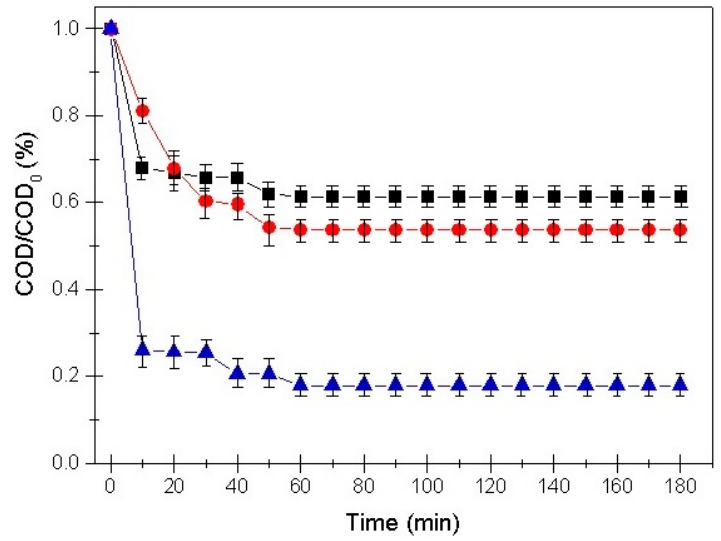
Figure 3. Removal capacity data for chemical oxygen demand (COD) from cold meat industry wastewater as a function of current density using pH = 7 and 298 K with 2 mAcm − 2 ( ■ ); 4 mAcm − 2 ( ● ), and 6 mAcm − 2 ( ▲ ).